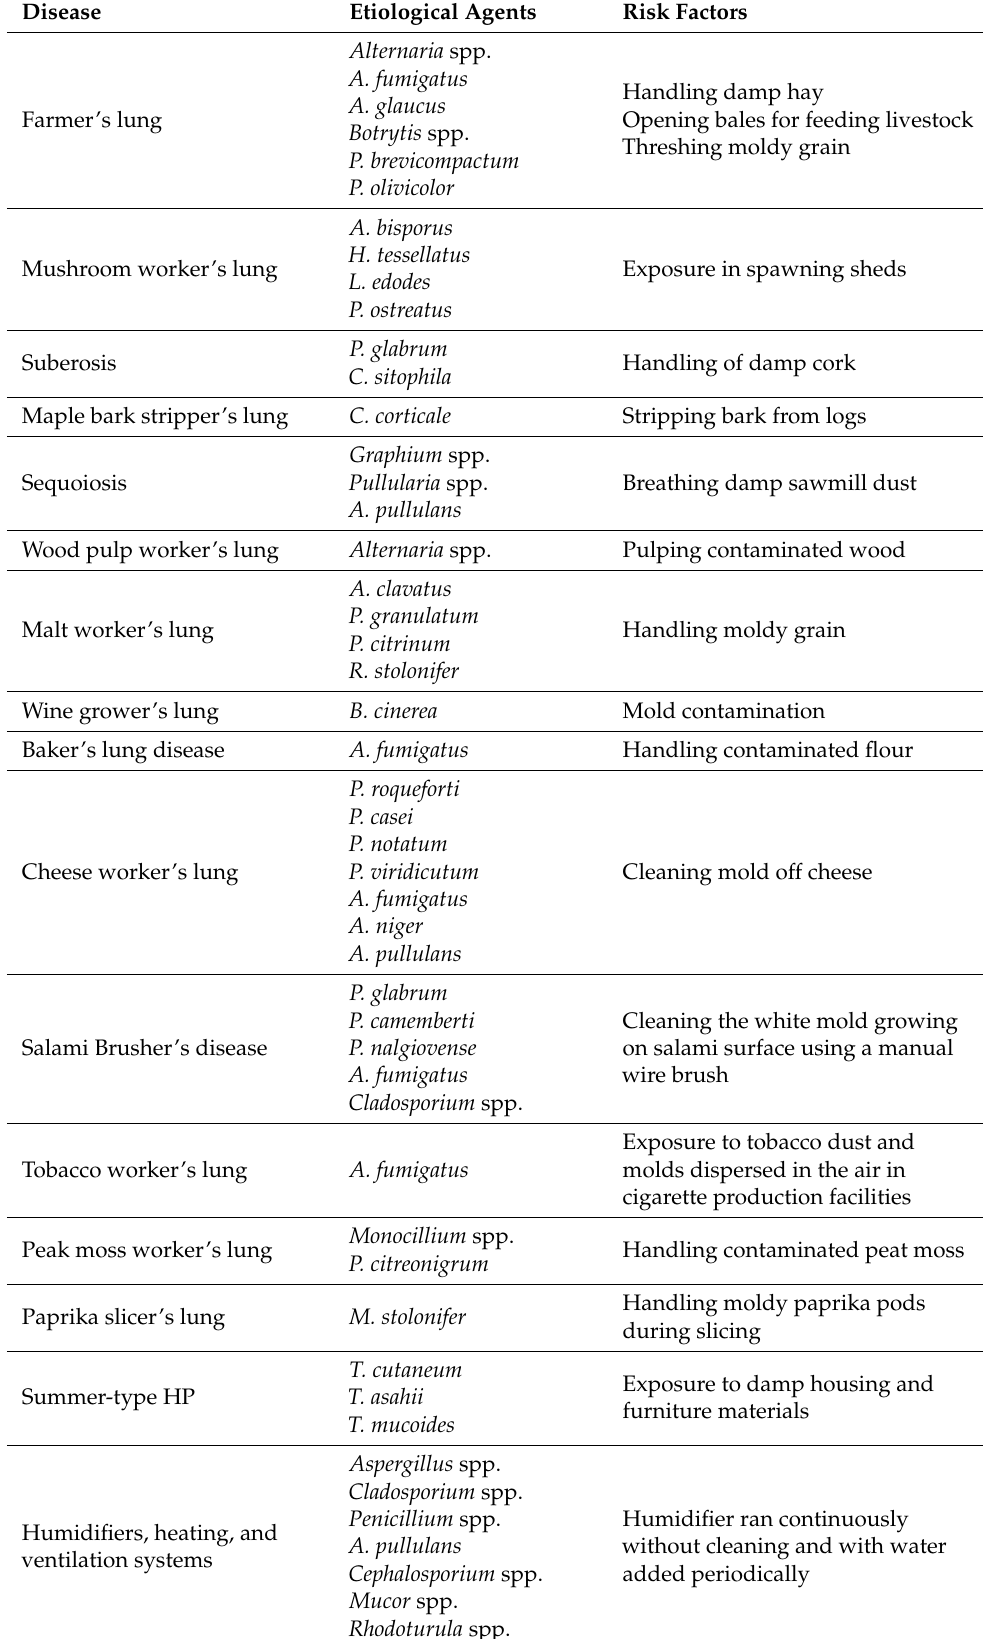
Table 2. Overview of the most common occupational fungal diseases.